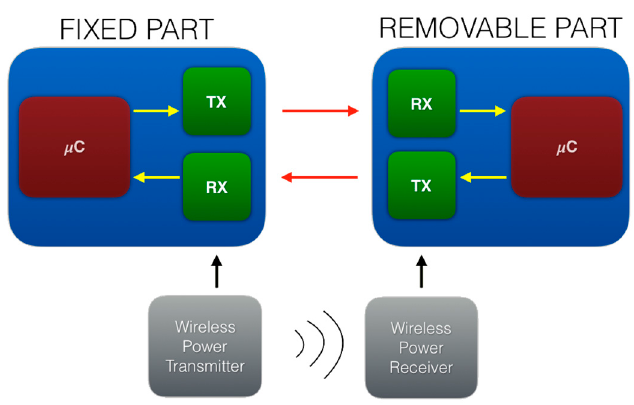
Figure 1. Block diagram of the system.